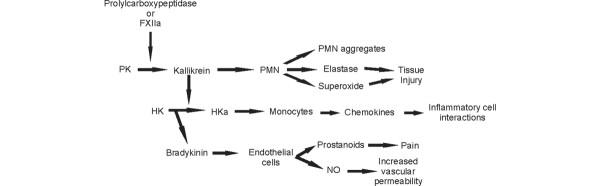
Kallikrein–kinin system (KKS). The KKS is initiated by factor XIIa (FXIIa) or prolylcarboxypeptidase on the endothelial cell and leukocyte (polymorphonuclear cell (PMN)) surface, generating the enzyme kallikrein, which in turn cleaves high-molecular-mass kininogen (HK) to yield bradykinin (BK) and cleaved high-molecular-mass kininogen (HKa). Kallikrein is chemotactic, aggregates neutrophils, and stimulates the release of elastase and superoxide (potent inducers of tissue injury). BK stimulates vasodilation, mediates pain through the release of prostaglandins, and stimulates vascular permeability through the generation of nitrous oxide (NO). PK, prekallikrein.